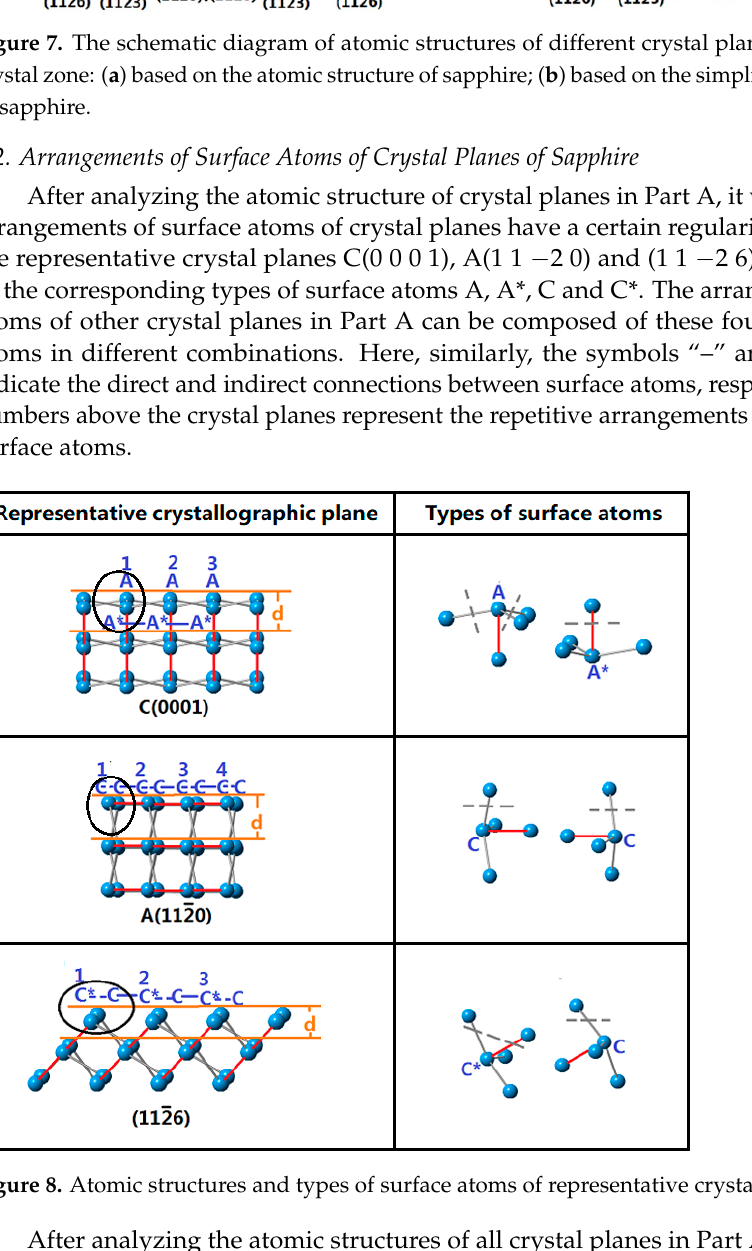
Figure 9. Atomic structures and types of surface atoms of basic crystal planes in Part A: ( a ) (1 1 − 2 0) plane; ( b ) (1 1 − 2 6) plane; ( c ) (0 0 0 1) plane; ( d ) (1 1 − 2 12) plane; ( e ) (1 1 − 2 18) plane. Thus, the arrangements of surface atoms of other crystal planes in Part A can be com- posed of these five basic units of surface atoms in different combinations, as shown in Figure 10. The arrangement of surface atoms on the (1 1 − 2 3) plane can be regarded as the combination of one “C--C” and one “C*--C”. The arrangement of surface atoms on the (1 1 − 2 8) plane can be regarded as the combination of one “C*--C--A*--A” and two “C*--C”. The arrangement of surface atoms on the (1 1 − 2 15) plane can be regarded as the combi- nation of one “C*--C--A*--A--A*--A” and one “C*--C--A*--A”. The arrangement of surface